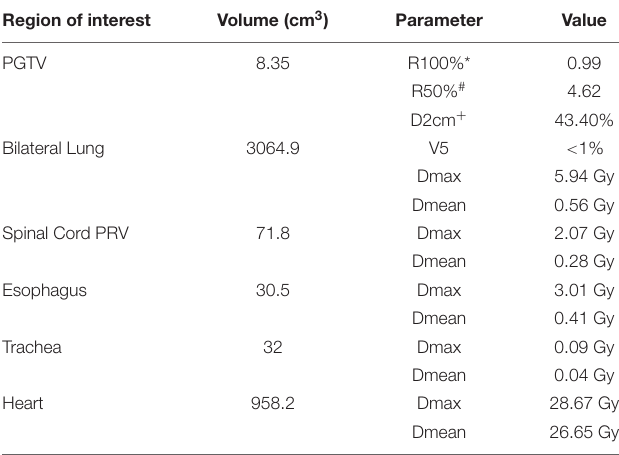
TABLE 1 | Dose statistics of the target area and OARs.